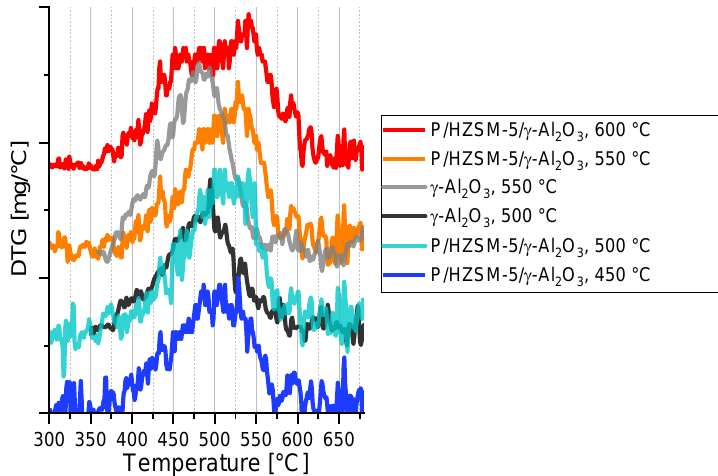
Figure 7. DTG curves from coke combustion after B:C ~4 using P/HZSM-5/γ-Al 2 O 3 and γ-Al 2 O 3 . Curves obtained at different catalyst temperatures have been shifted vertically to facilitate comparison.